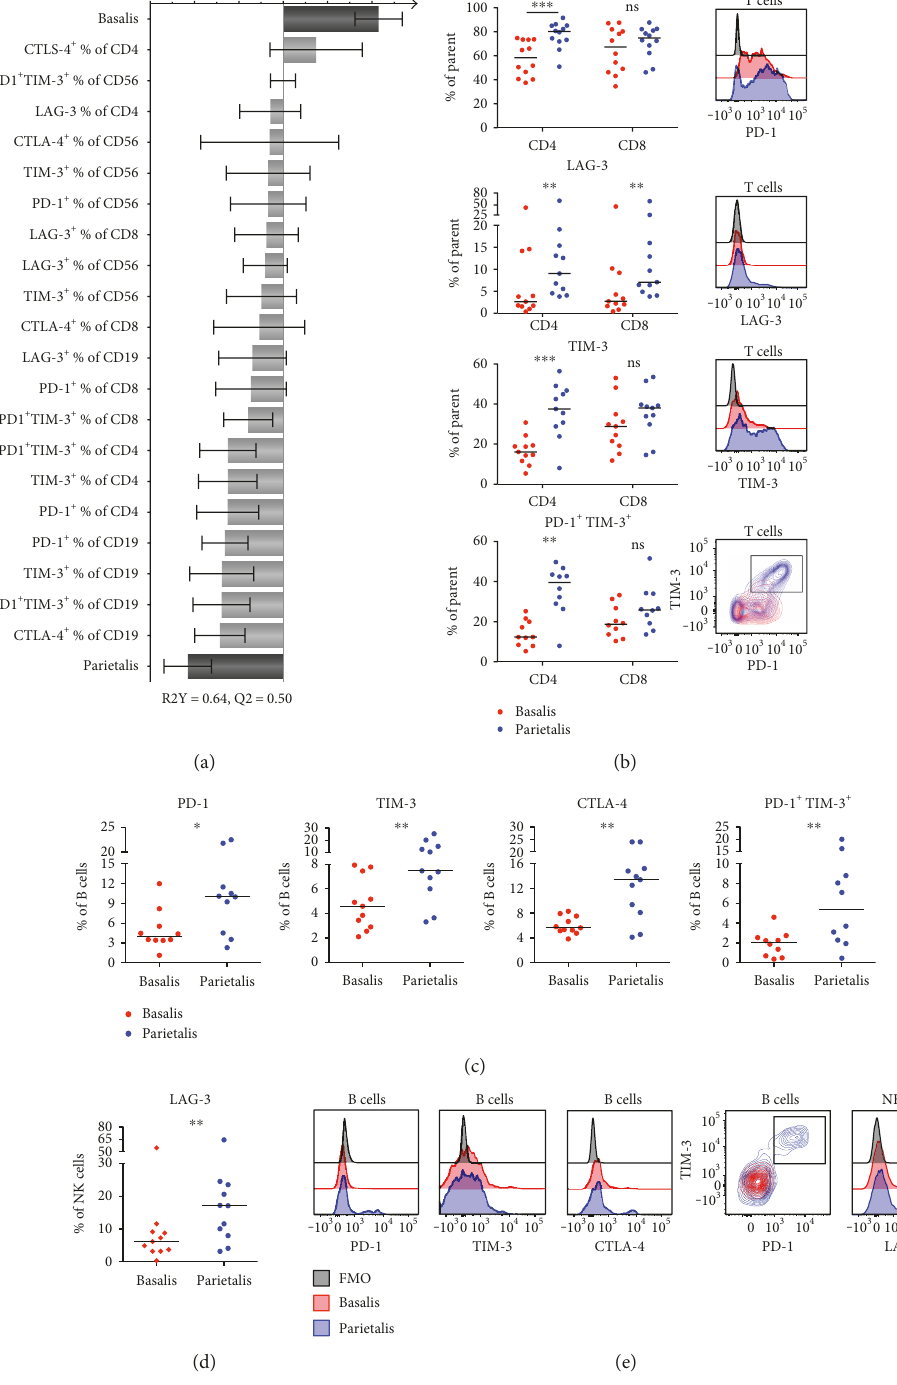
Figure 2: Lymphocytes in decidua parietalis express more coinhibitory markers compared to basalis. (a) OPLS plot showing associations between decidual compartment and phenotypic coinhibitory markers ( n =10 – 12). (b) Surface expression and representative histograms and contour plots showing the expression of the indicated extracellular markers on decidua basalis and parietalis T cells (CD3 + ) compared to the fl uorescent minus one (FMO) control of PD-1 ( n = 12 ), LAG-3 ( n = 11 ), TIM-3 ( n = 11 ), and PD-1 + TIM-3 + ( n = 10 ). (c) B cell (CD19 + ) surface expression of PD-1 ( n = 10 ), TIM-3 ( n = 11 ), CTLA-4 ( n = 11 ), and PD-1 + TIM-3 + ( n = 10 ). (d) NK cell (CD56 + CD3 − ) surface expression of LAG-3 ( n = 11 ). (e) Representative histograms and contour plots showing the expression of the indicated extracellular markers on decidua basalis and parietalis cells from (c) to (d) compared to the fl uorescent minus one (FMO) control. Line in graphs depicts the median. Comparisons between the paired samples were made using the nonparametric Wilcoxon test. ns=not signi fi cant; ∗ p < 0 05 ; ∗∗ p < 0 01 ; ∗∗∗ p < 0 001